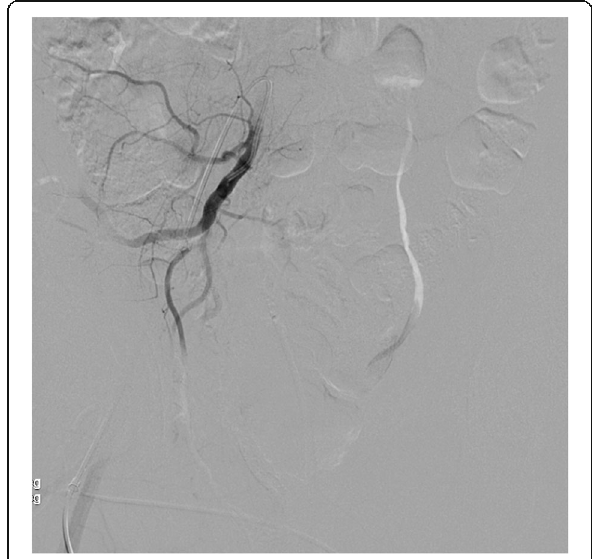
Fig. 5 Totally necrotized tumor and underlying bladder